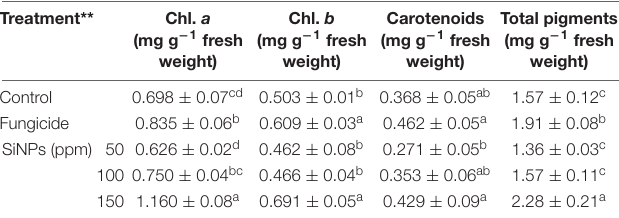
the second spray.*